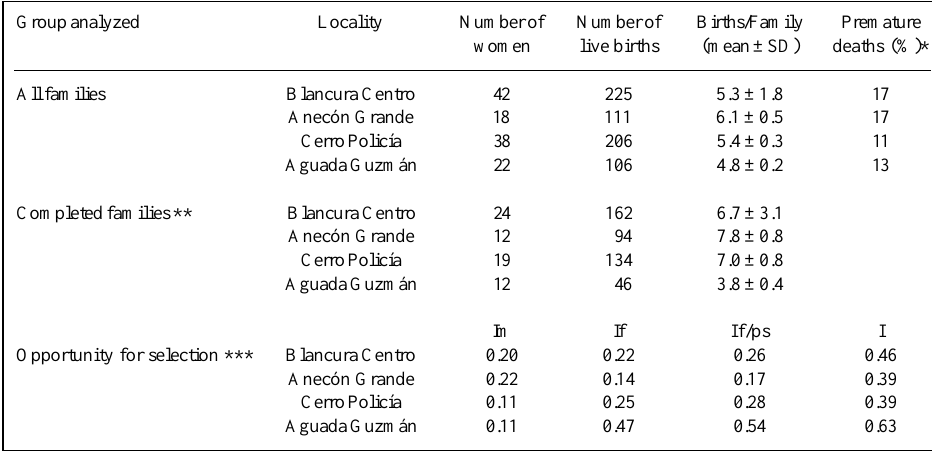
Table II - Fertility and mortality of the Indian populations studied.